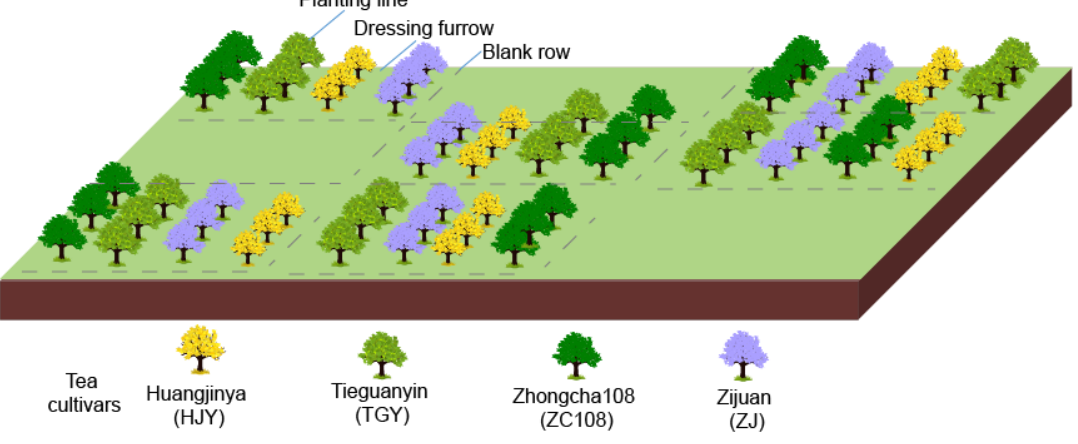
Figure 1. Schematic diagram of the experimental plot.